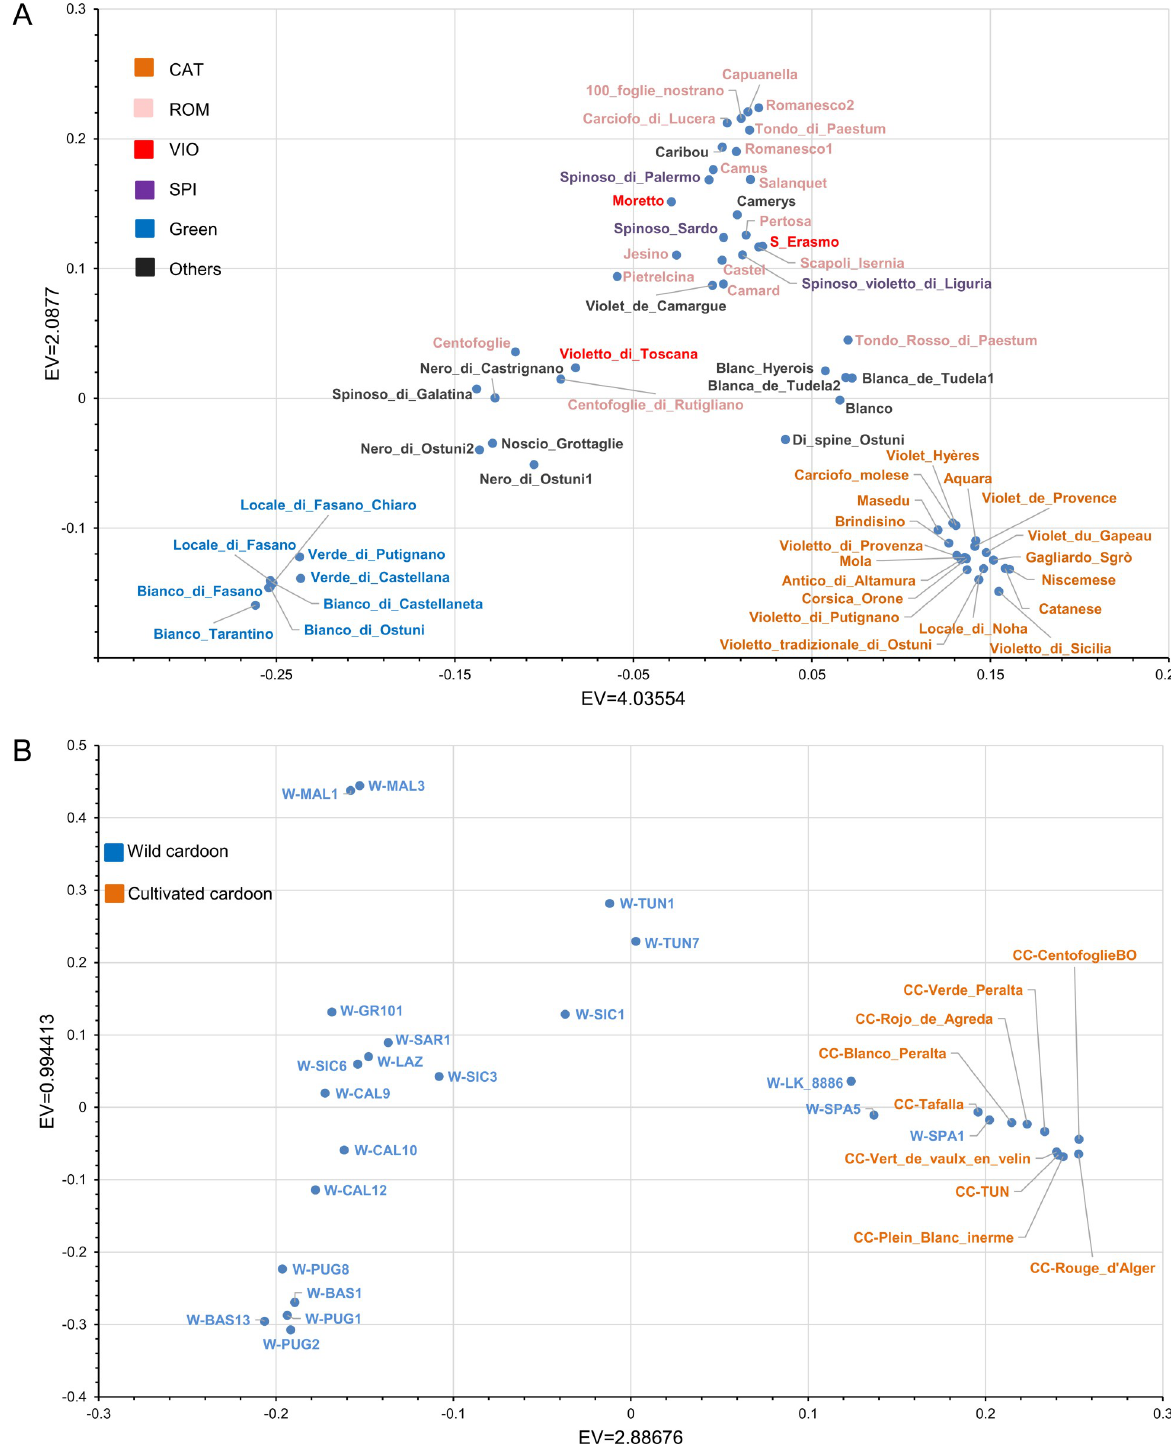
Fig 4. Graph of the first two axes from a Principal component analysis (PCA) of (A) 62 globe artichoke and (B) 30 wild and cultivated cardoon genotypes. EV: eigenvalue. Colors indicate globe artichoke types (A), or wild or cultivated cardoon (B). CAT: Catanesi: ROM: Romaneschi; VIO: Violetti; SPI: Spinosi; Green: Green Apulian artichokes; Others: other types.